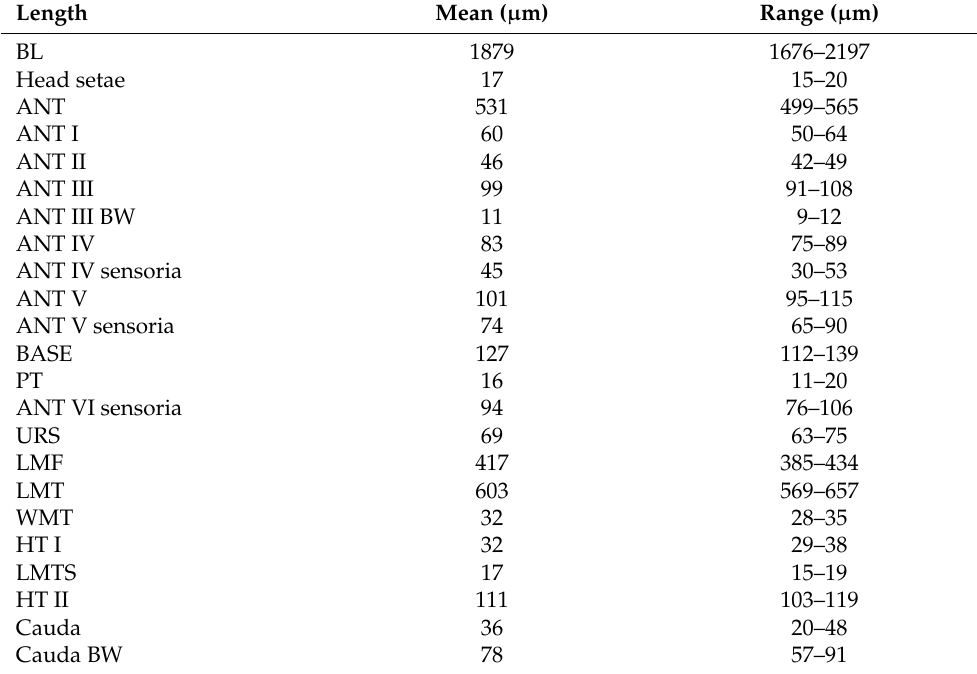
Table 3. Measurements (in µ m) of alate viviparae (n = 14) of Qiao jinshaensis sp.